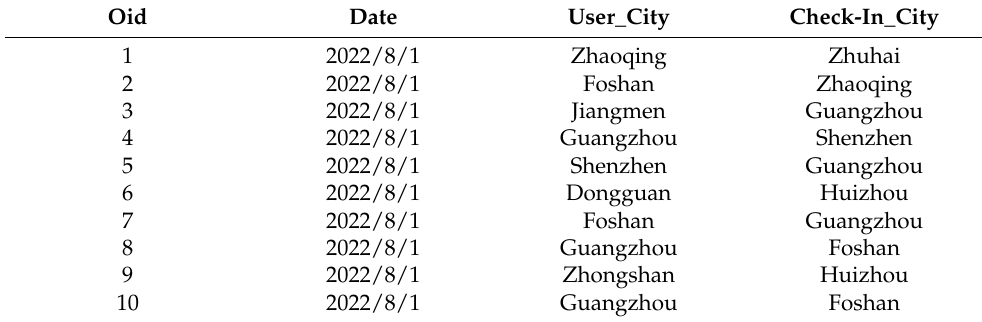
Table 1. Cross-city check-in data samples.